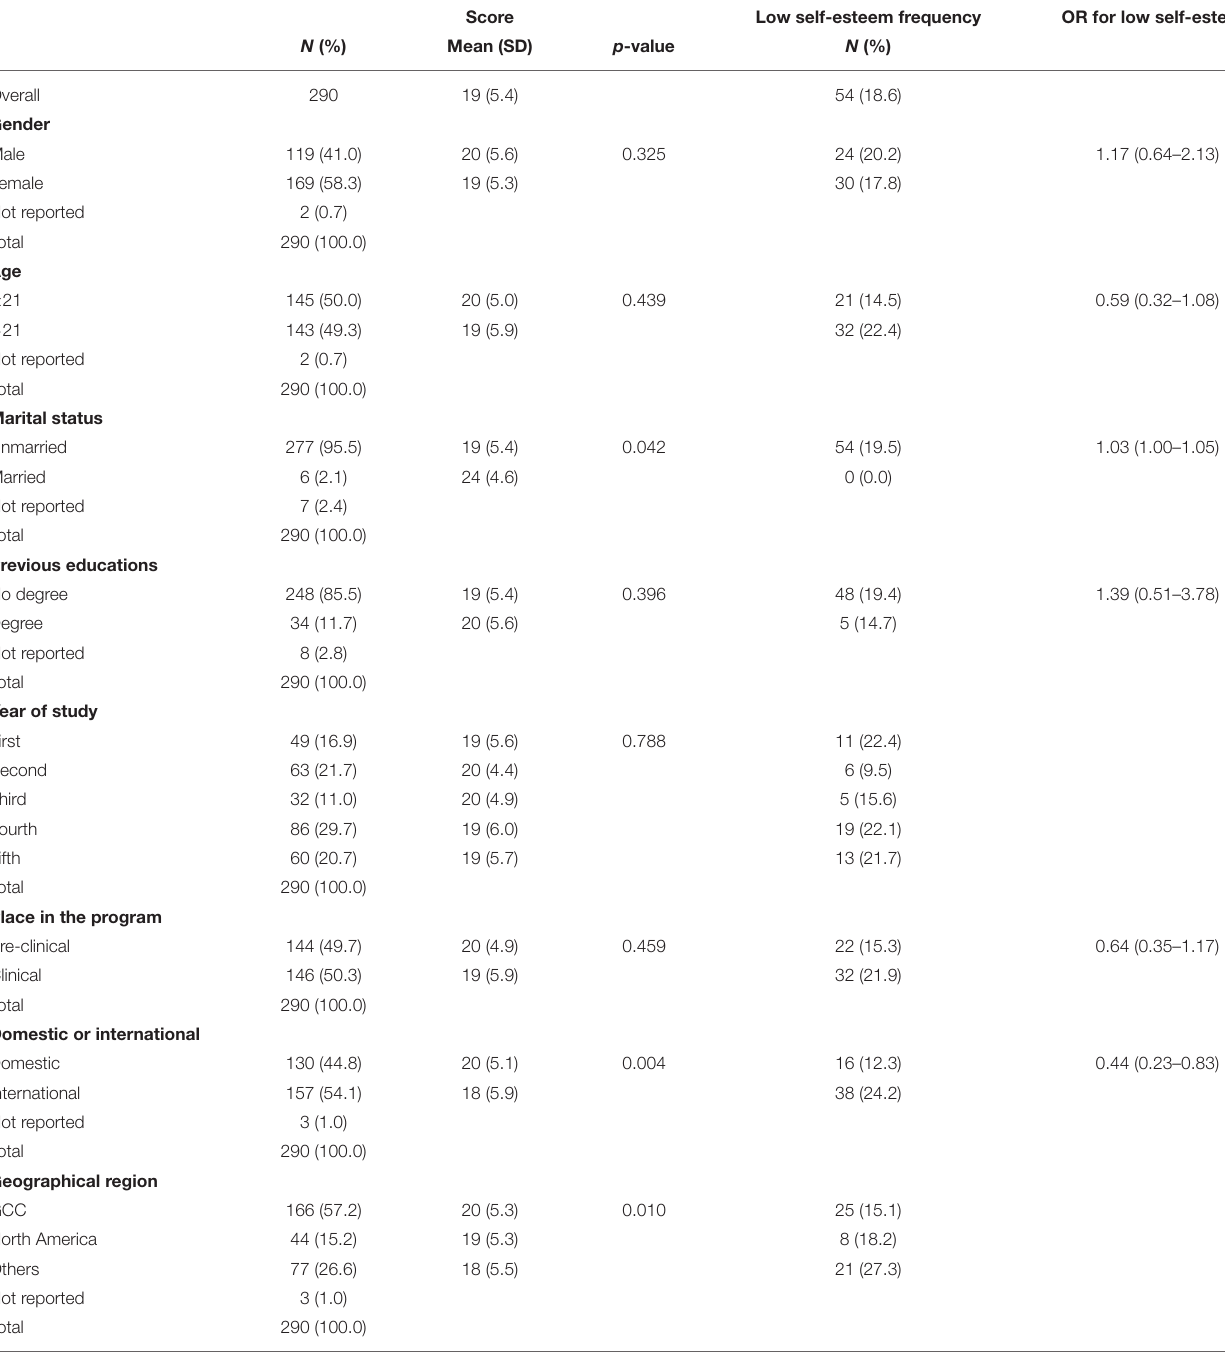
TABLE 3 | Mean student’s scores on the Rosenberg’s Self-Esteem Scale and frequency of low self-esteem. Score Low self-esteem frequency OR for low